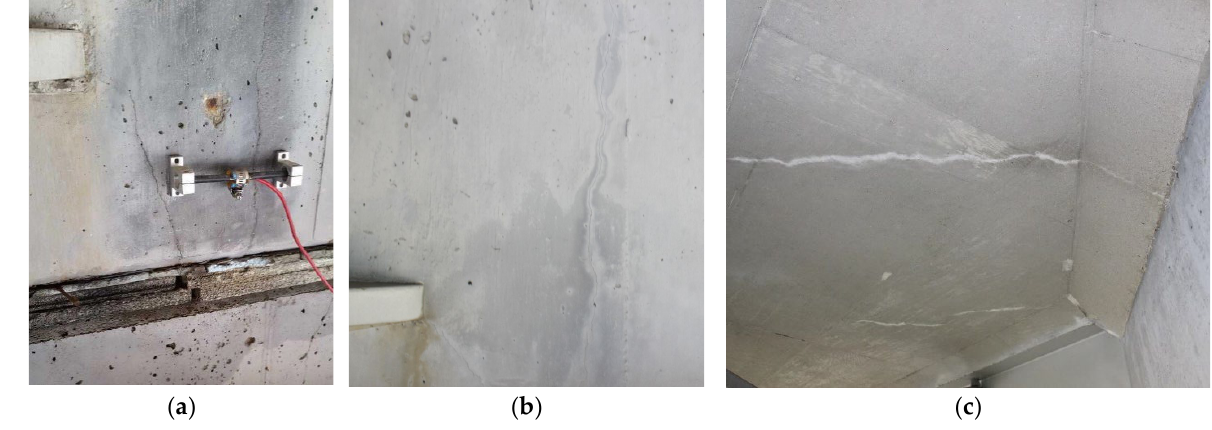
Figure 4. Typical cracks at each girder ( a ) vibrating wire strain gauge located near girder #2, ( b ) cracks forming in diaphragm ( c ) cracks forming in bridge deck.